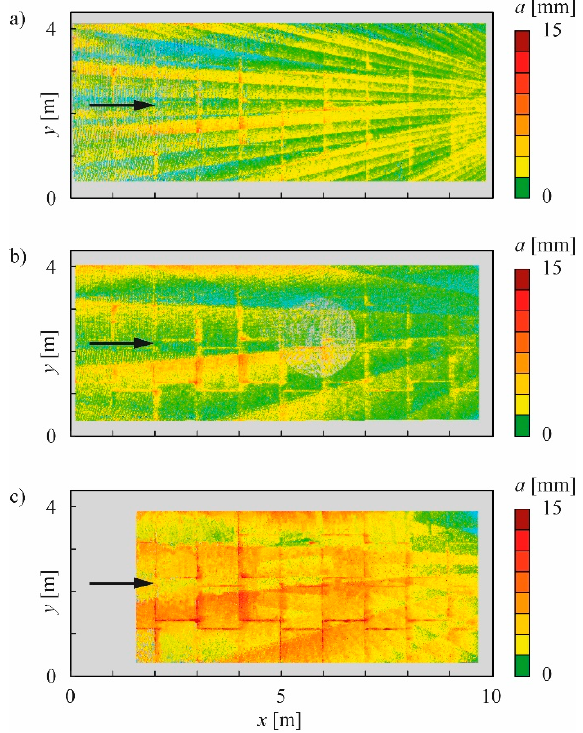
Figure 7. High-resolution abrasion maps of the 10 m long granite test field G1 installed at test location 1 in Pfaffensprung SBT after ( a ) one, ( b ) two and ( c ) four operational years (blue colored points mark theoretically negative abrasion depths corresponding to detection uncertainty; grey colored areas could not be scanned due to ground water drainage installation).